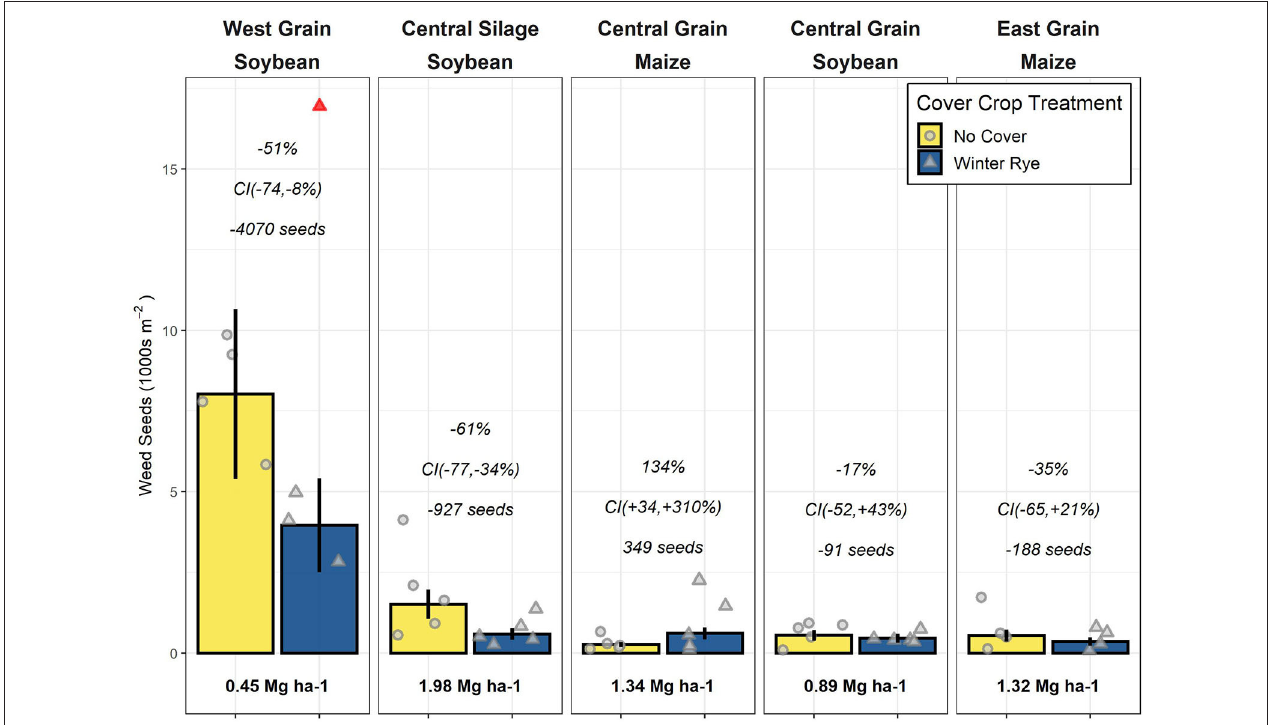
FIGURE 1 | Weed seed densities for no-cover and winter rye ( Secale cereale ) cover crop plots (points jittered for ease of viewing) with a removed outlier indicated in red; panel titles present the trial location, cropping system type, and previous year’s cash crop; bars represent mean seed densities with standard errors of the means indicated by the vertical lines; italicized text presents the ( top ) estimated change from no-cover to cover treatments within a trial on a relative scale, ( middle ) 90% confidence intervals (CIs) of the relative change, and ( bottom ) the absolute difference in seeds per m − 2 . Bold text below bars presents the 10-years mean cover crop biomass production for that